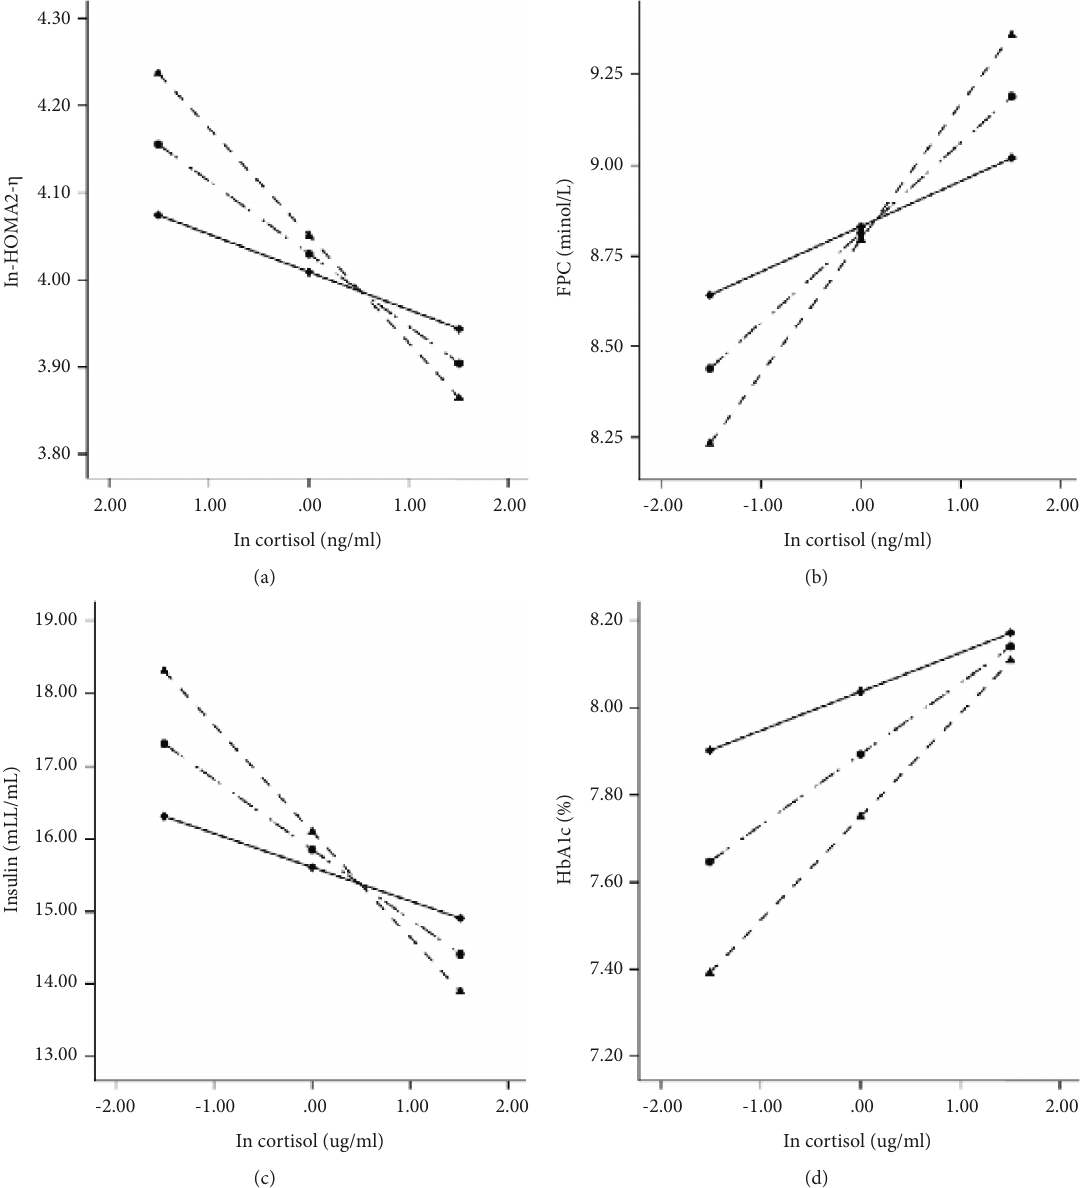
Figure 1: Associations between cortisol and cardiovascular metabolic risk factors for low, medium, and high levels of 25 (OH)D. The associations ofcortisoland ß cellfunction,FPG,fasting insulin,andHbA1c moderatedby 25(OH)Dwereshownas(a), (b),(c),and(d),respectively. Themodel included the following covariates: age, gender, educational level, average monthly individual income, smoking status, alcohol consumption, physical activity, high fat diet, vegetables and fruits intake, and family history of T2DM. Δ : low levels; Ο : medium levels; ∇ : high